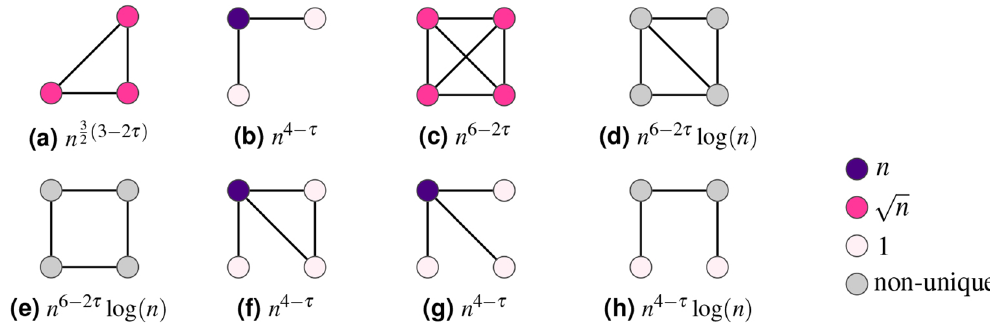
Figure 1. Scaling of the expected number of motifs on 3 and 4 vertices in n , where the vertex color indicates the dominant vertex degree. Vertices where the optimizer is not unique are